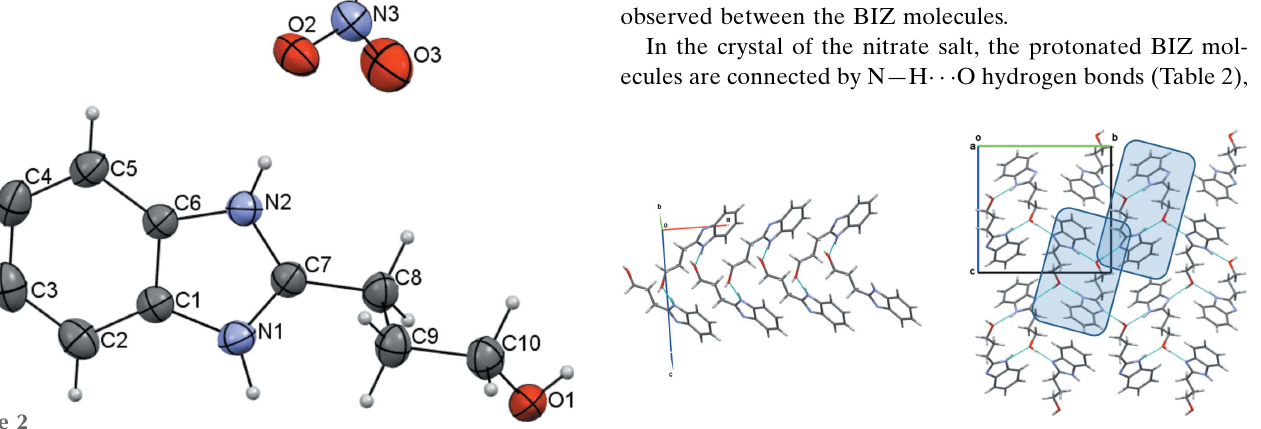
Figure 3 Crystal packing of the neutral molecules in the BIZ structure. Projection in the [100] direction.